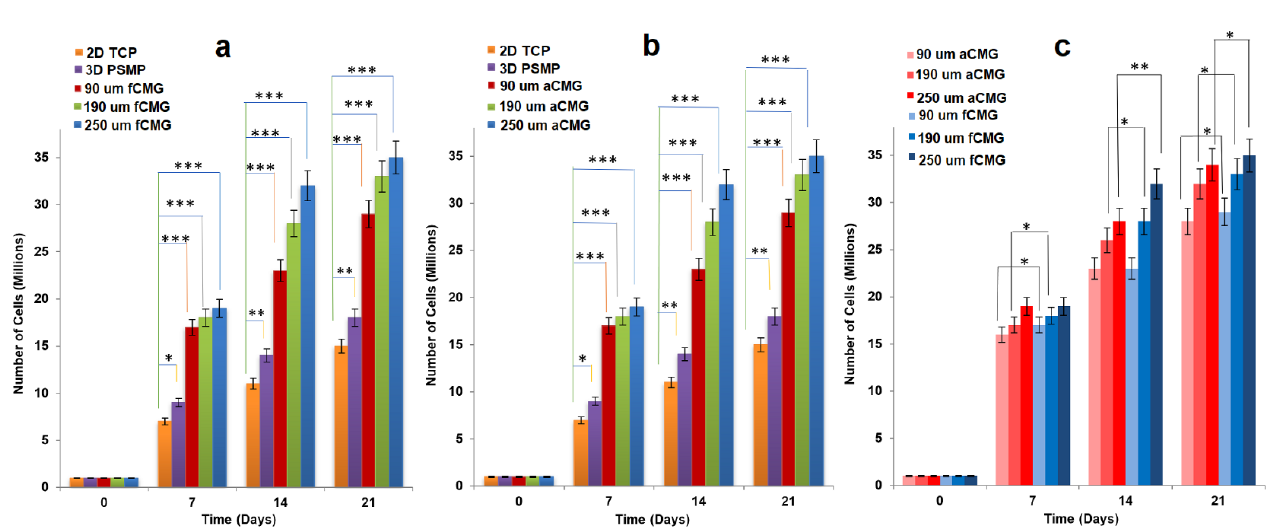
Figure 2. The growth of hMSCs on fetal ( a ) and adult ( b ) CMGs with culture time in basal medium in a tissue culture bioreactor for CMG sizes of 90 (red), 190 (green), and 250 μm (blue); hMSCs grown on 2D tissue culture plates (orange) and 3D polystyrene beads (purple) were used as controls; ( c ) comparison of hMSCs grown on fetal (blue) and adult (red) CMGs with culture time in basal medium for CMG sizes of 90 (light), 190 (medium), and 250 μm (dark); one asterisk (*), two asterisks (**), and three asterisks (***) indicate a statistically significant difference between two experimental groups at a given time point at the levels of p < 0.05, p < 0.01, and p < 0.001, respectively.